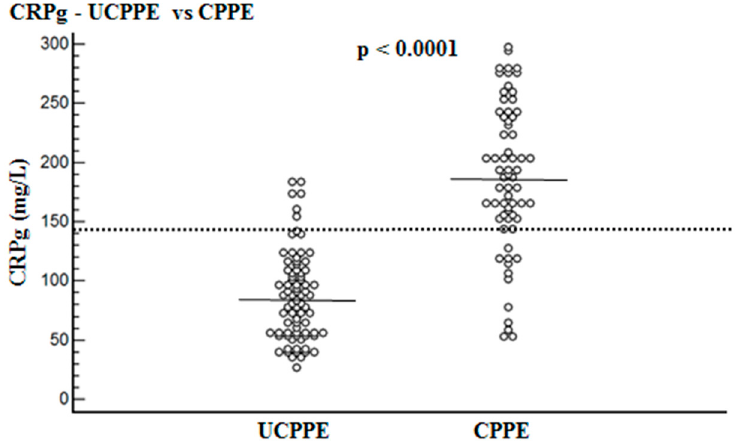
Figure 2. Pleural fluid CRP levels (CRPpf) and their means for uncomplicated parapneumonic effusion (UCPPE) group (58.5 mg/L) and complicated parapneumonic effusion (CPPE) group (112.0 mg/L), and best cut-off value (90.5 mg/L) for discrimination between UCPPE and CPPE. For both parameters p < 0.0001.